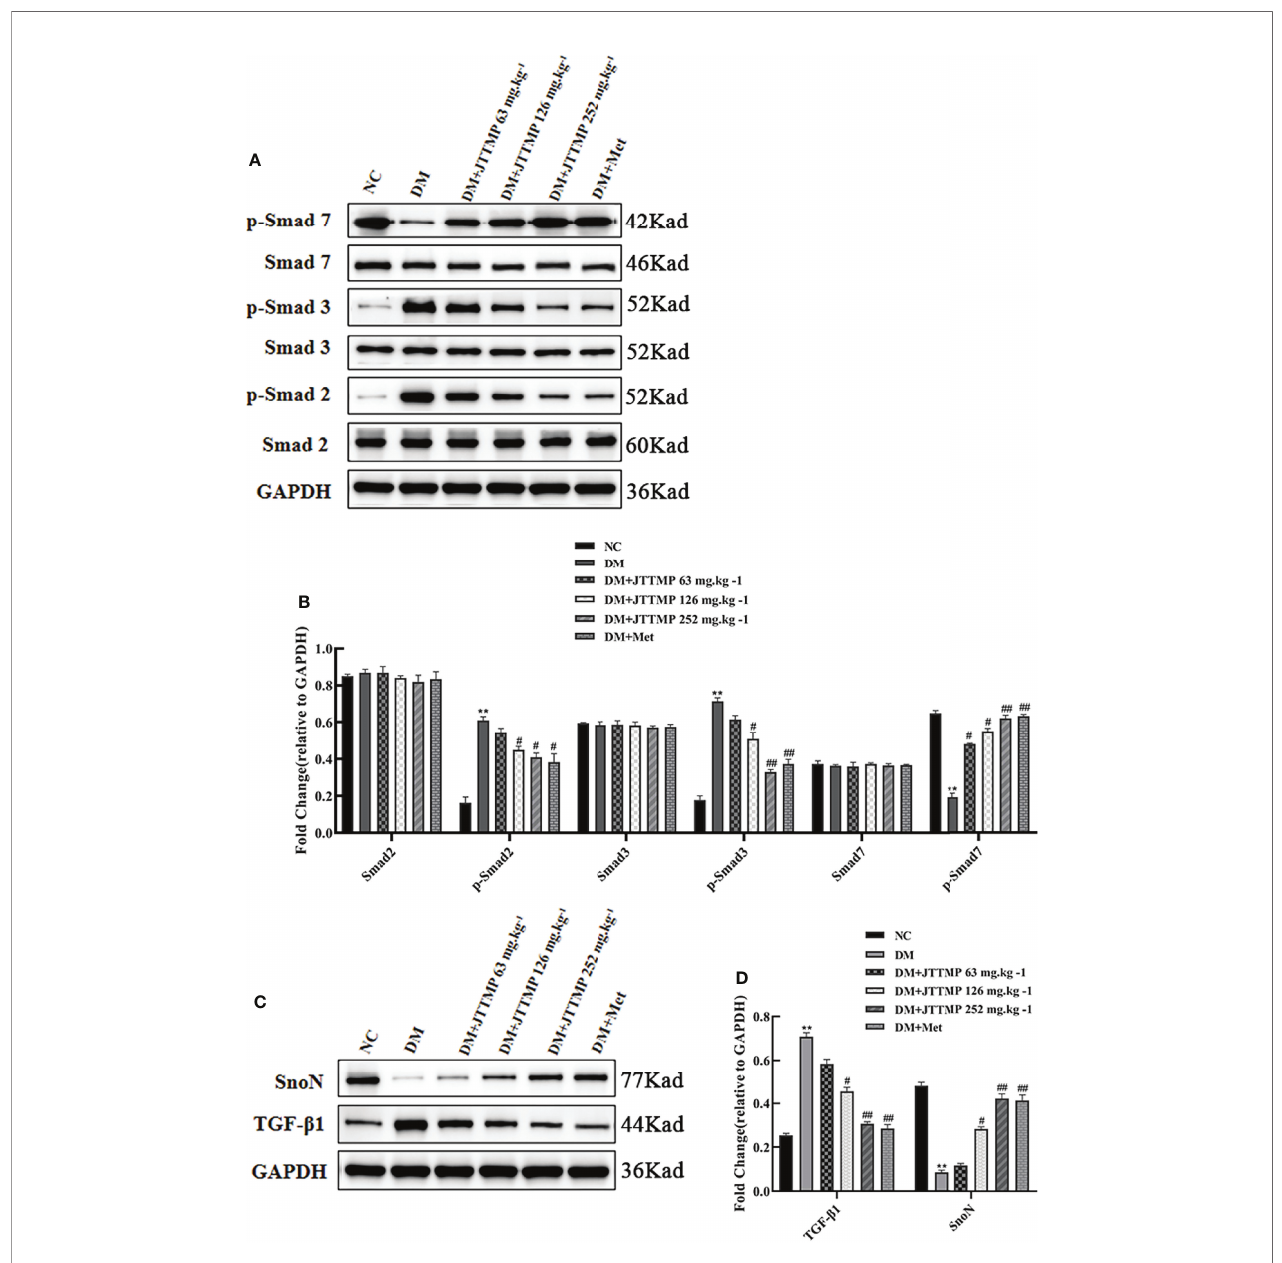
FIGURE 3 | Western blot analysis of TGF- b 1/Smads expression in lung tissue of rats from different groups. (A) Smads protein family expression in the lung of rats from different groups; (B) Quantitative analysis of Smads protein family expression; (C) TGF-b1 and SnoN expression in lung tissue of rats from different groups; (D) Quantitative analysis of TGF-b1 and SnoN expression. ** P <0.01; vs DM group, # P< 0.05, ## P<